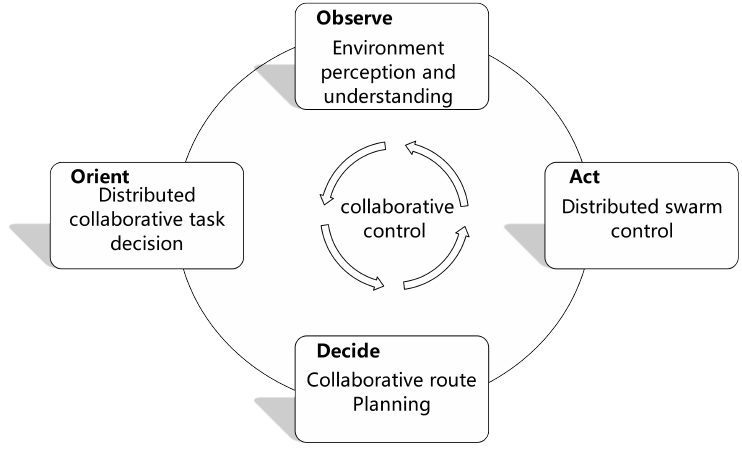
Figure 11. The self-organizing architecture.